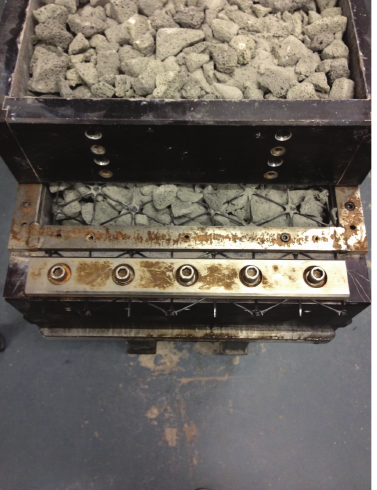
Figure 3: Shear box after completion of an interface shear test.